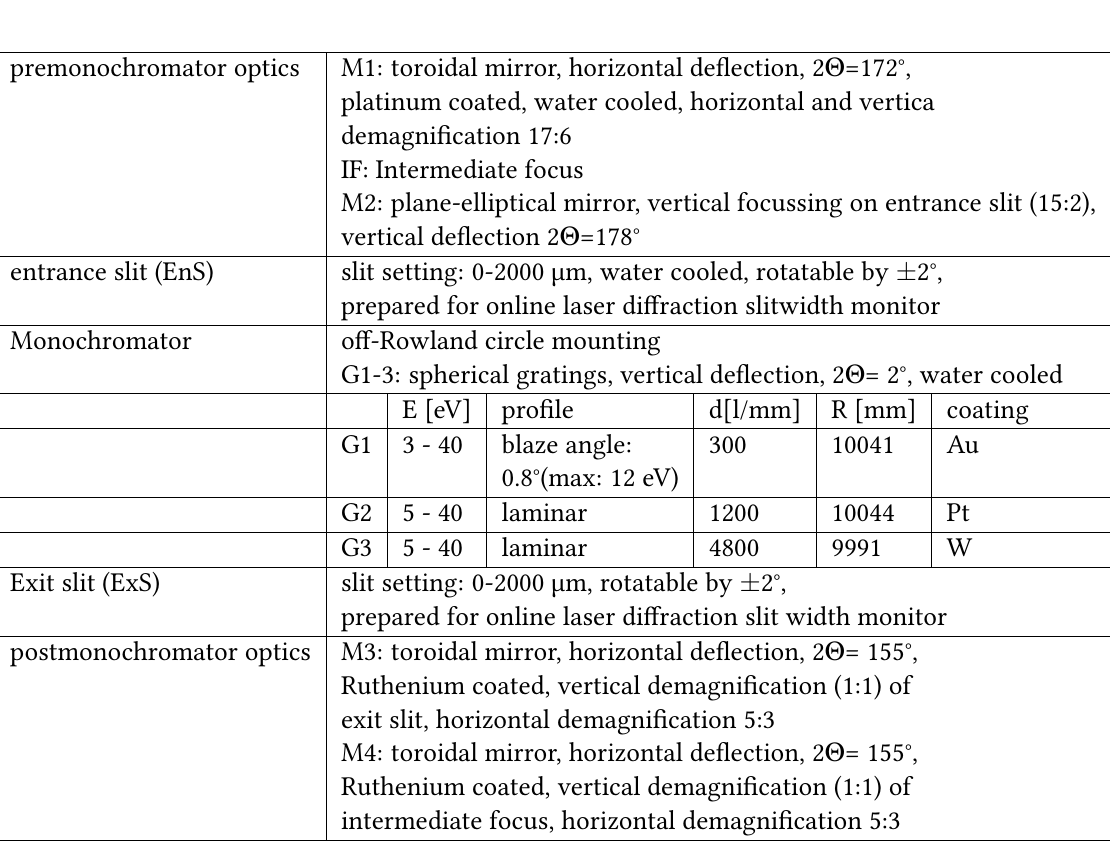
Table 2: Description of the optical